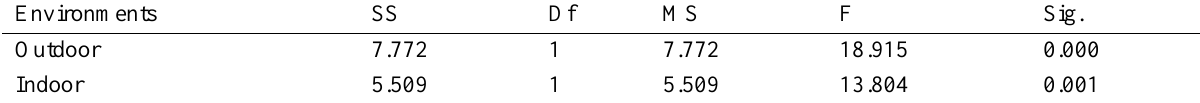
Table 5. Variance analysis of heavy metal concentrations in indoor and outdoor stations Environments SS Df MS F Sig. Outdoor Indoor